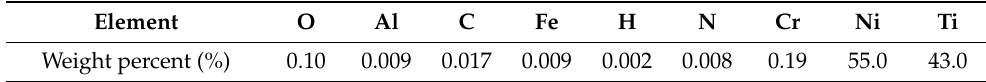
Table 1. Chemical composition of NiTi powder (provided by manufacturer). Element O Al C Fe